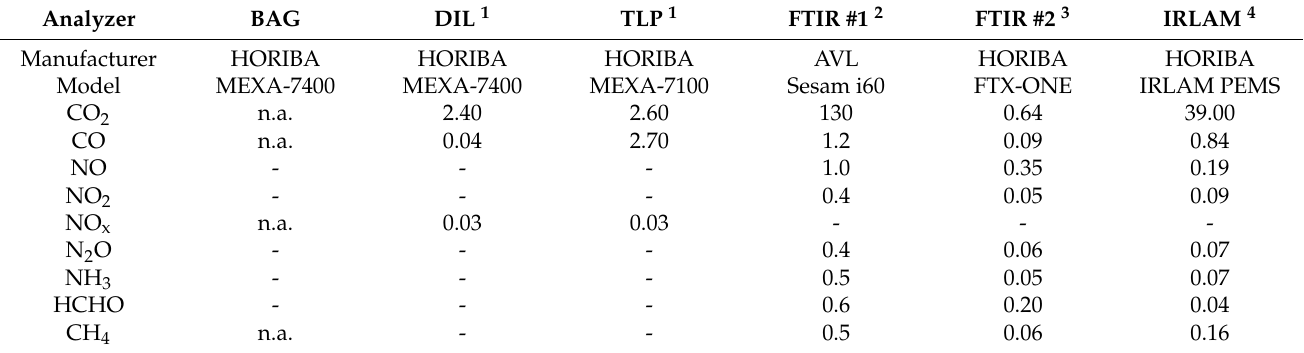
Table A2. Zero levels defined as two standard deviations of 30 s measurement of zero gas (N 2 ) at the inlet of the sampling lines (except IRLAM at the inlet of the calibration line). The values were obtained at the lowest range. Not products